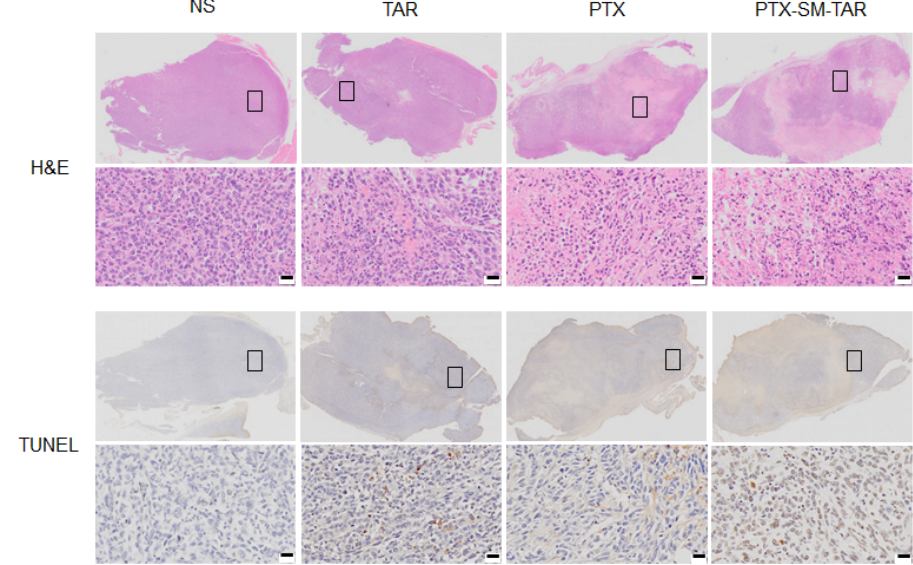
Figure 10. H&E and TUNEL staining images of tumor tissues at the end of treatment. The scale bar is 50 μ m. The black box part in the upper image was enlarged by 400 times to obtain the corresponding local image below.